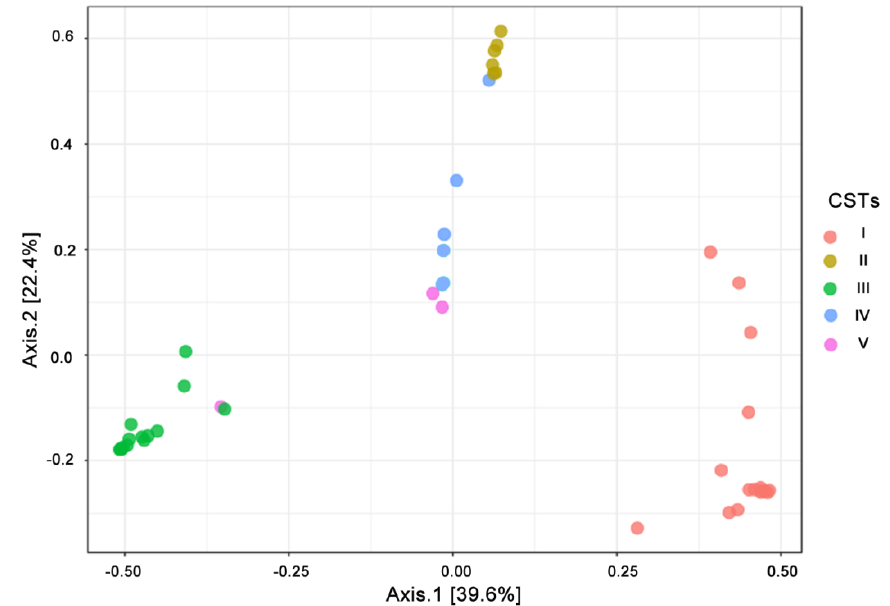
Figure 2. Beta diversity measure. Principal Coordinate Analysis (PCoA) ordination based on Bray Curtis dissimilarities correlated with community state types (CSTs) (permutational multivariate analysis of variance (PERMANOVA) 999 permutations; R2 = 0.740 p -value < 0.001). Samples belonging to different CSTs are indicated with different colour dots.